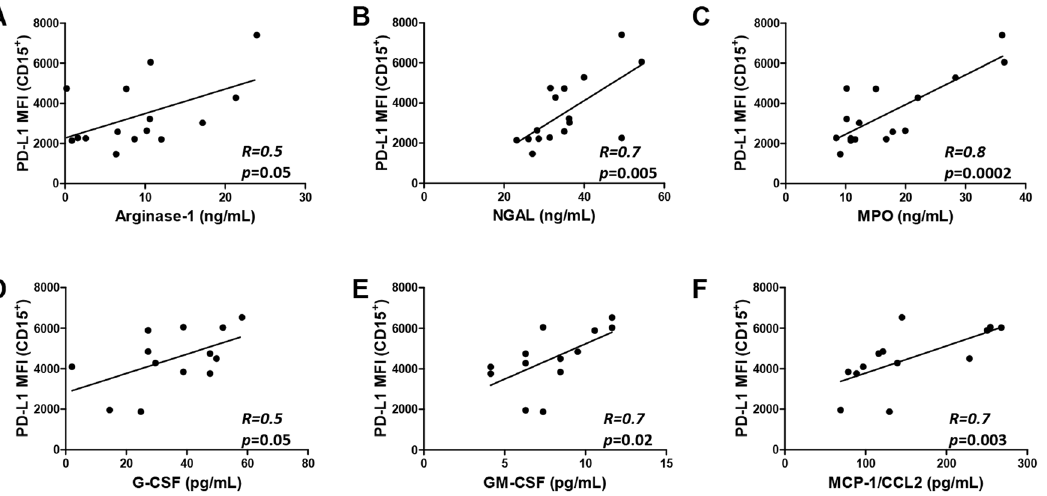
Figure 5. Neutrophil PD-L1 expression correlates with elevated levels of markers of neutrophil degranulation invivo . A–C) PD-L1 expression on neutrophils correlates with plasma levels of arginase-1 (A), neutrophil gelatinase-associated lipocalin (NGAL) (B), and myeloperoxidase (MPO) (C) (N=16). Analyzed by Pearson product-moment correlation test; D’Agostino & Pearson omnibus normality test of normal distribution of data passed for all populations ( a =0.05). D–F) PD-L1 expression on neutrophils correlates with plasma levels of G-CSF (D), GM-CSF (E), and MCP-1/ CCL2 (F) in HIV-1-infected donors (N=13).